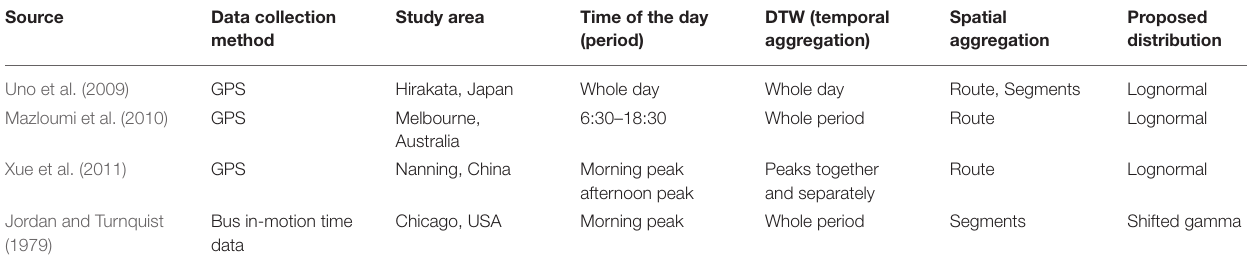
TABLE 2 | Compilation of studies examining running times.